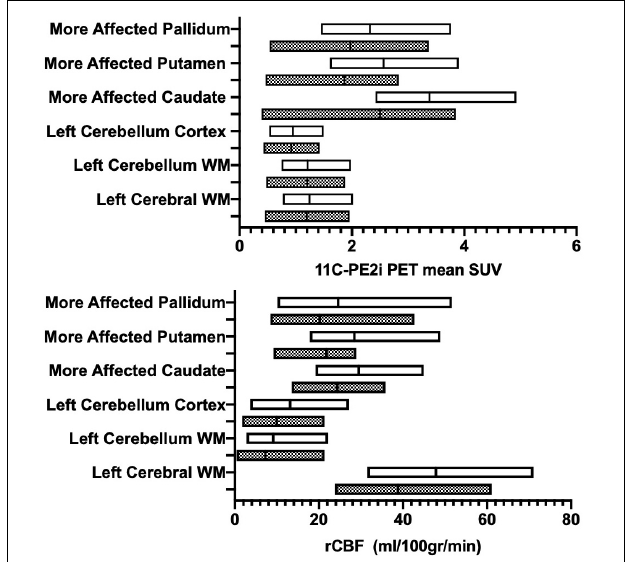
FIGURE 3 | Patients with Parkinson disease (PD) stratified by disease duration ( > 5 years, gray boxes; ≤ 5 years, white boxes). Region-specific ASL-based rCBF values (x-axis - A ) and PE2I-based mean SUV (x-axis- B ) are provided. Y-axis denotes evaluated brain regions.